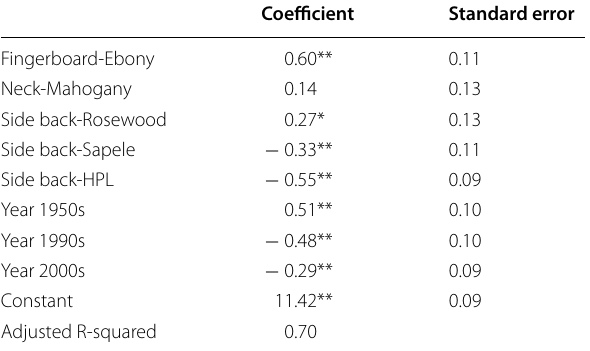
Table 3 Multiple regression analysis results for Martin guitars